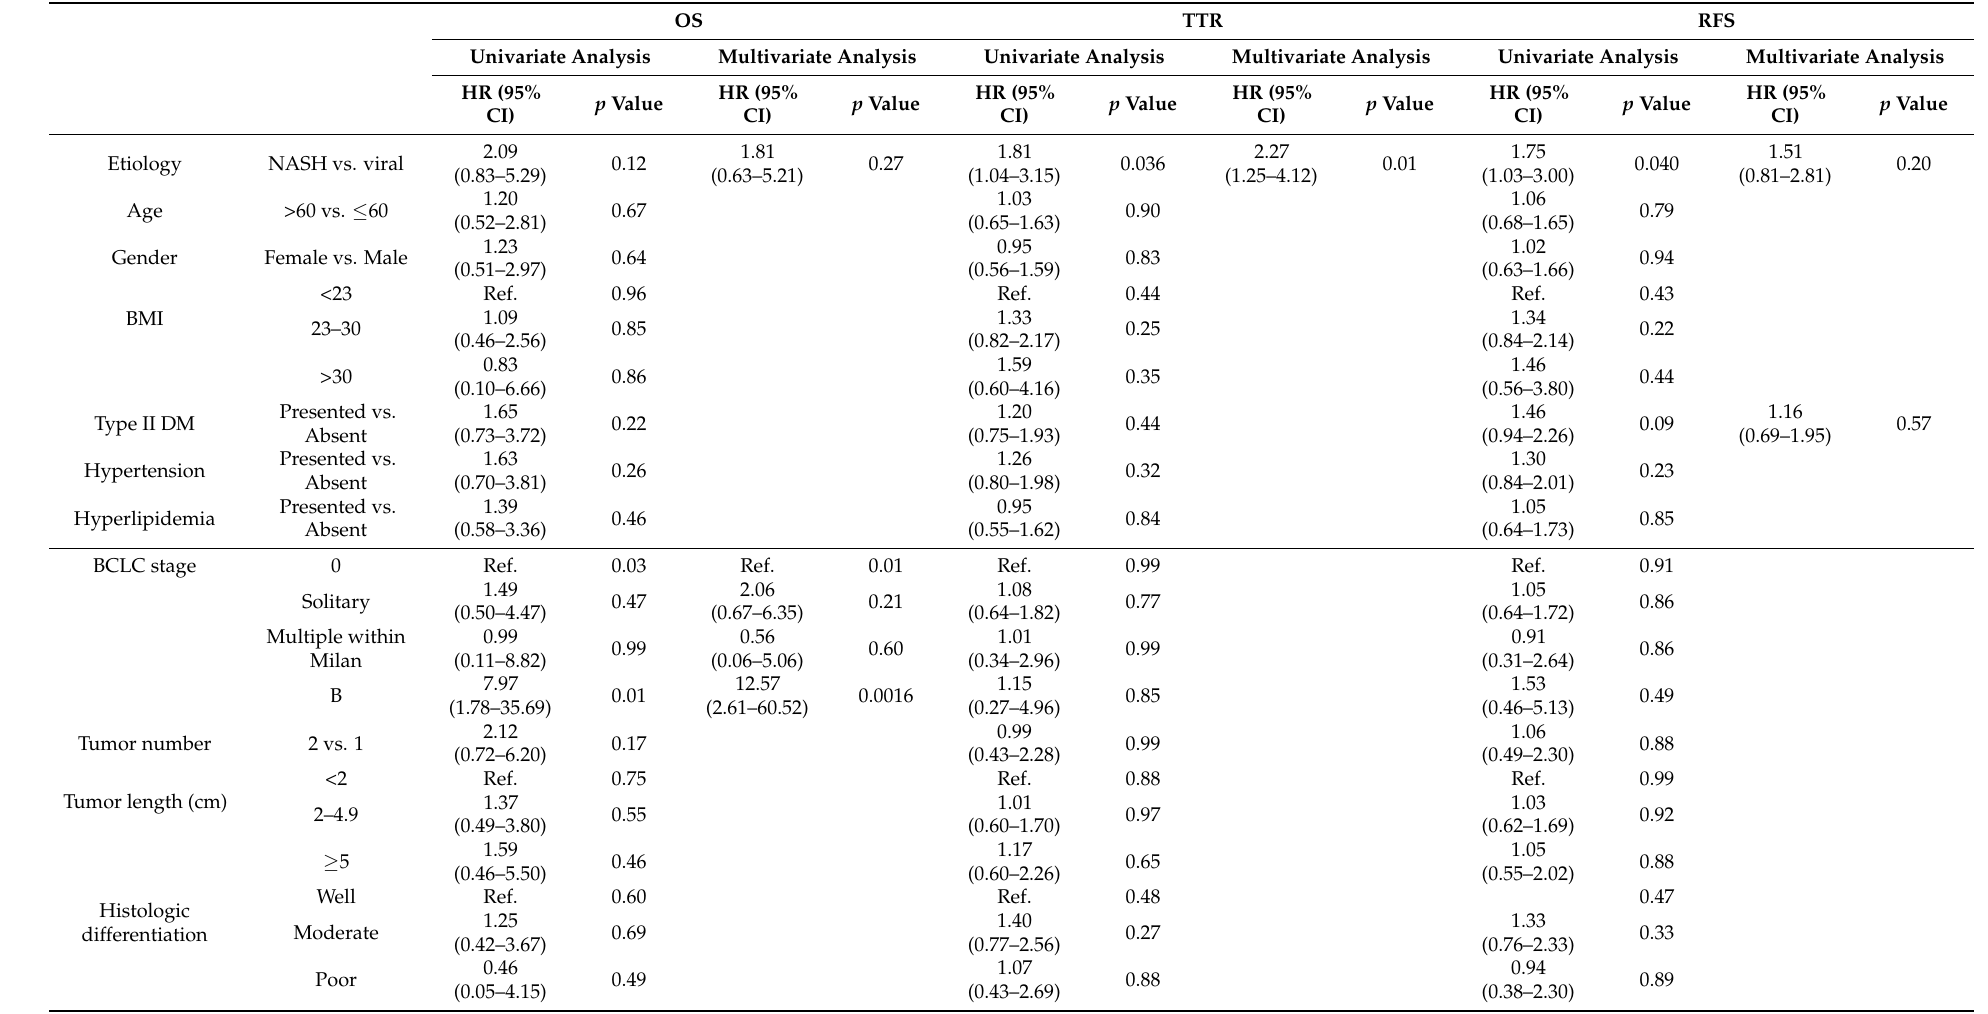
Table 2. Univariate and multivariate analysis for outcomes, including overall survival (OS), time-to-recurrence (TTR), and recurrence-free survival (RFS). OS TTR RFS Univariate Analysis Multivariate Analysis Univariate Analysis Multivariate Analysis Univariate Analysis Multivariate